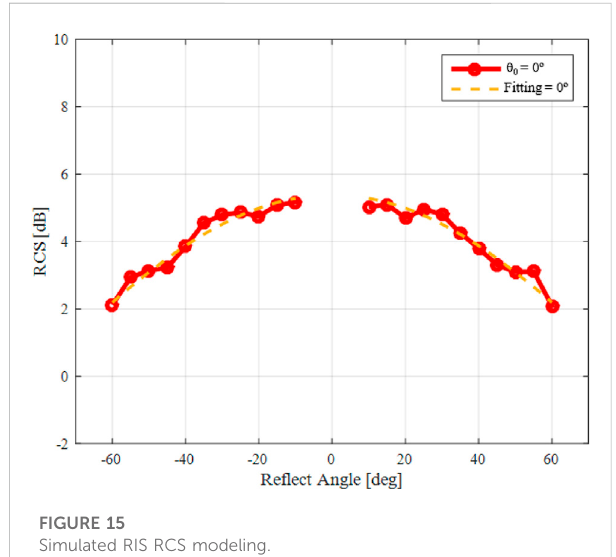
FIGURE 15 Simulated RIS RCS modeling.